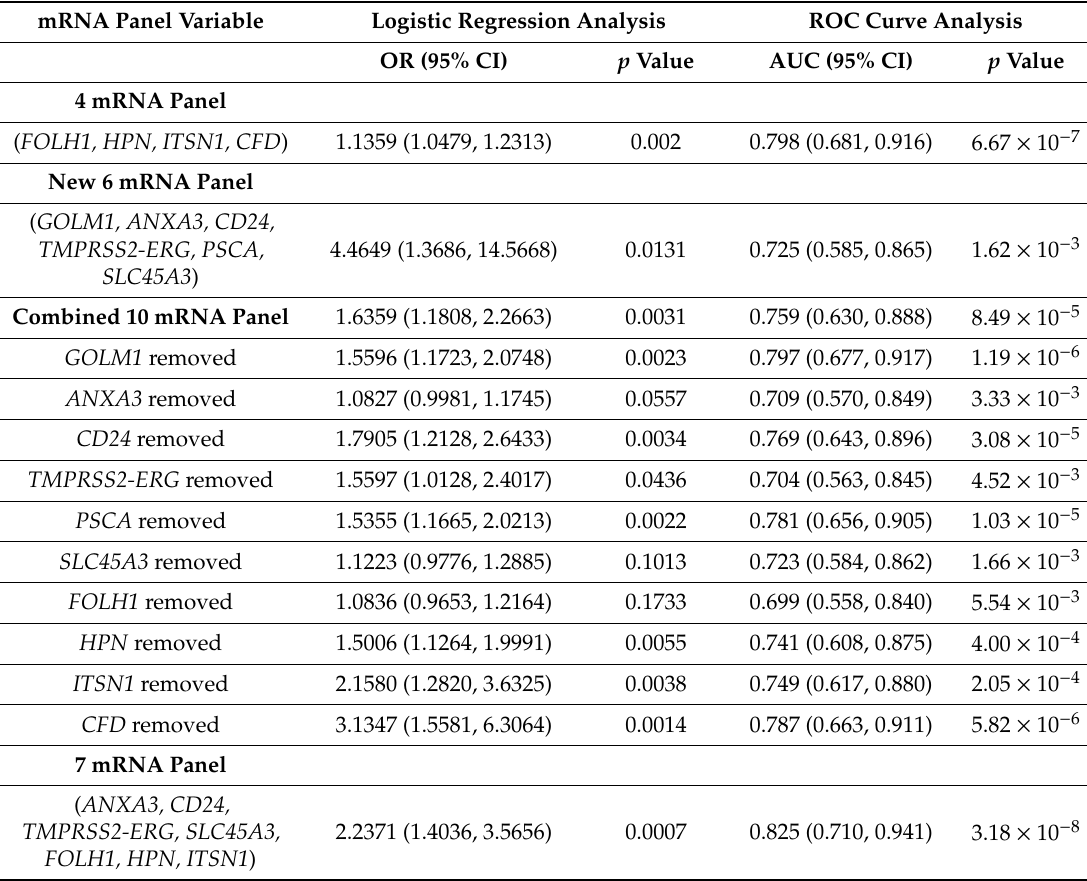
Table 3. Performance of urinary Vn96-isolated EV reference-free mRNA biomarker panels for prostate cancer prediction and